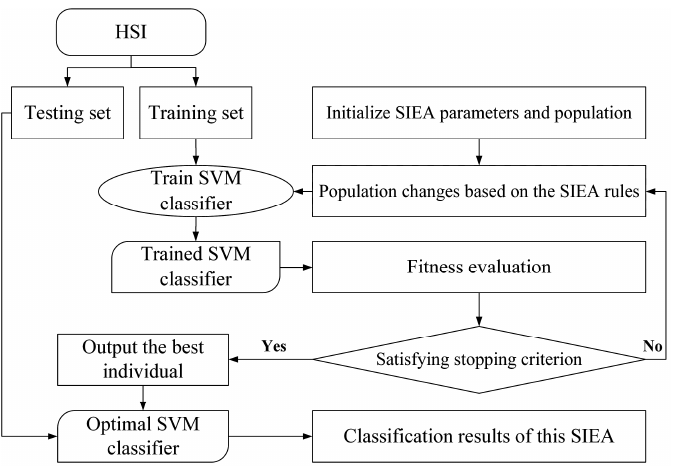
Figure 2. Standard process for optimizing SVM classification based on each SIEA.